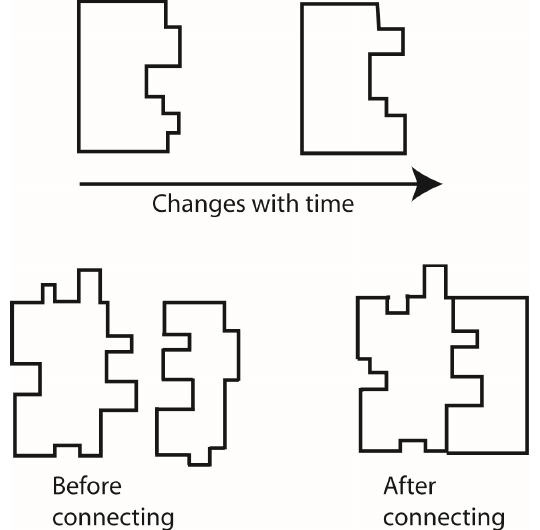
Figure 7. Dynamic evolution of information. The relationships between information elements can change over both time and by the act of connecting